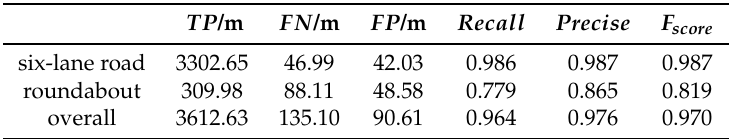
Table 1. Lane mapping